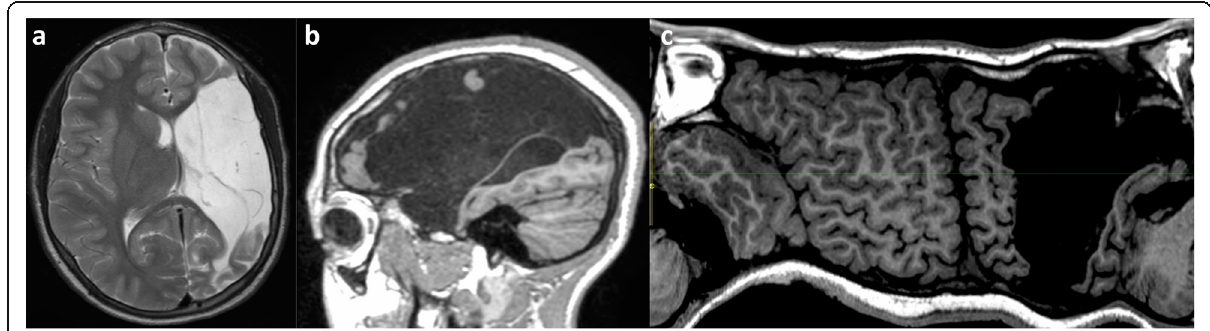
Fig. 17 a – c MRI scan in a 14-year-old girl with a chronic left MCA infarct. Axial T2-weighted image ( a ), sagittal T1-weighted image ( b ) and Mercator map derived from the curved reconstruction of 3D T1 images ( c ) show the unilateral sharply demarcated cystic encephalomalacia involving the arterial territory of the left MCA. Notably, there is involvement of the left temporal lobe, the deep nuclei and the inferolateral aspect of the frontal lobe with sparing of the parasagittal region and superior frontal gyrus, i.e. the watershed. The involvement of the superior temporal lobe which is not a feature of parasagittal extension in severe partial-prolonged hypoxic-ischaemic injury in term neonates can be appreciated, especially on the sagittal image ( b ). The Mercator map derived from the curved reconstruction of 3D T1 images ( c ) confirms the unilateral left MCA territory cystic change and provides an overview comparing the left with the right side of the brain. It also shows that the inter-hemispheric fissure and superior frontal gyrus are relatively preserved (i.e. not expanded/separated through